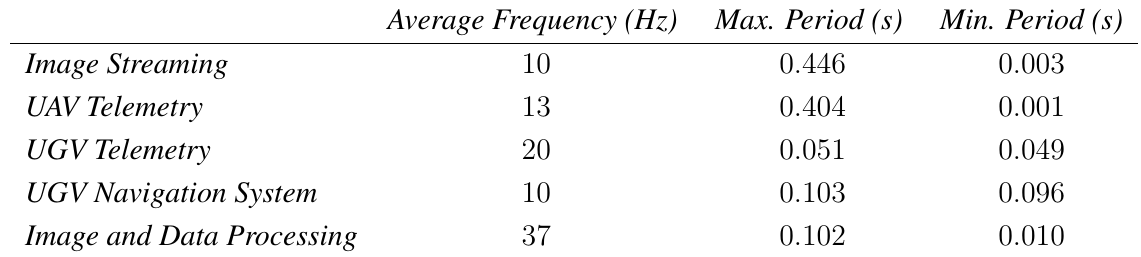
Table 3. Frequencies and Time Consumption for image and data streaming and processing.